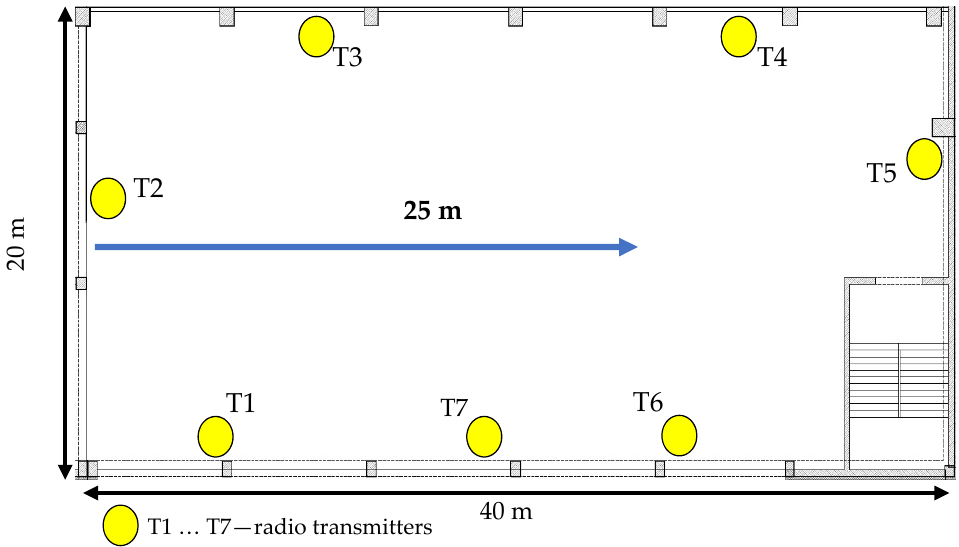
Figure 14. Example route of the terminal (in test scenario 2), marked with a blue arrow.